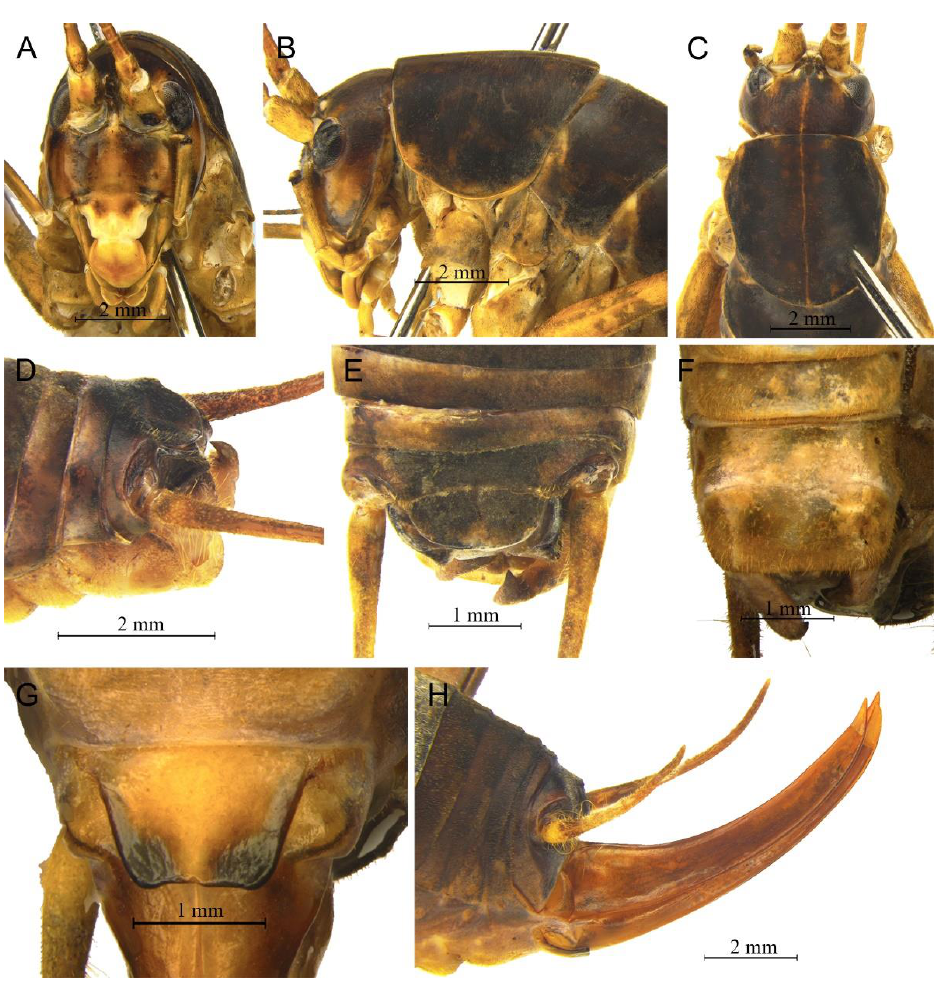
genitalia triangular, apical area broadly concave; basal area of dorsal median lobe with paired lateral sclerites, quadrangular, apical area not divided; dorsal lateral lobes little longer than dorsal median lobe, basal area broad, gradually narrowing to apices, apical area sclerotized, hooked; ventral median lobe and ventral lateral lobes very short. Subgenital plate quadrangular, wide, posterior margin straight. dorsal spines and two pairs of ventral spines, intero-dorsal spine slightly shorter than hind basitarsus. Hind basitarsus with one dorsal apical spine. Posterior margins of all abdominal tergites straight. Epiproct semicircular; paraproct simple, triangular in lateral view. Cercus slender, conical, apex acute. Dorsal sclerite of genitalia quadrate, apical area slightly concave; basal area of dorsal median lobe with paired lateral sclerites, crescent-shaped, apical area not divided; dorsal lateral lobes little longer than dorsal median lobe, basal area broad, gradually narrowing to apices, apical area sclerotized, hooked; ventral median lobe and ventral lateral lobes short. Subgenital plate trapezoidal, posterior margin straight.